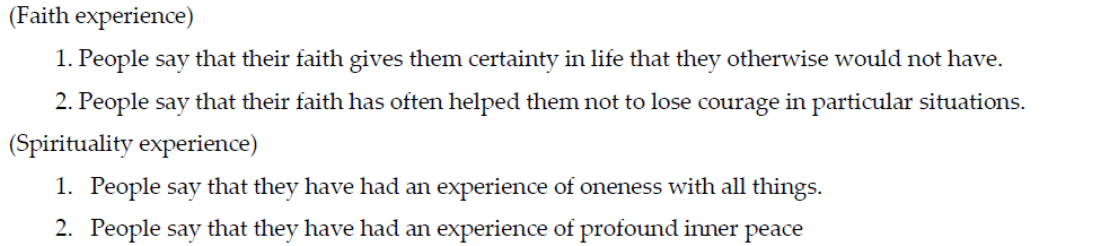
Figure 4. Dimensions of the concept of ‘faith and spirituality experiences’.